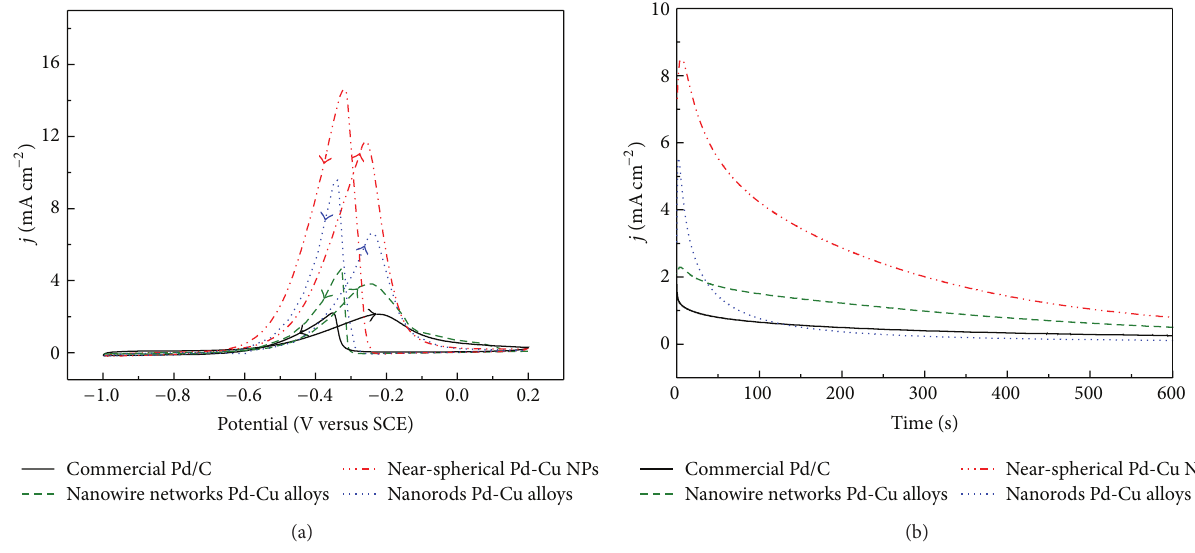
Figure 7: (a) CV curves and (b) CA curves (at − 0.25 V versus SCE) of modified electrodes for commercial Pd/C, near-spherical Pd-Cu NPs, nanorods Pd-Cu alloys, and nanowire networks Pd-Cu alloys in 0.5 M KOH containing 1.0M ethanol at a scan rate of 50 mVs −1